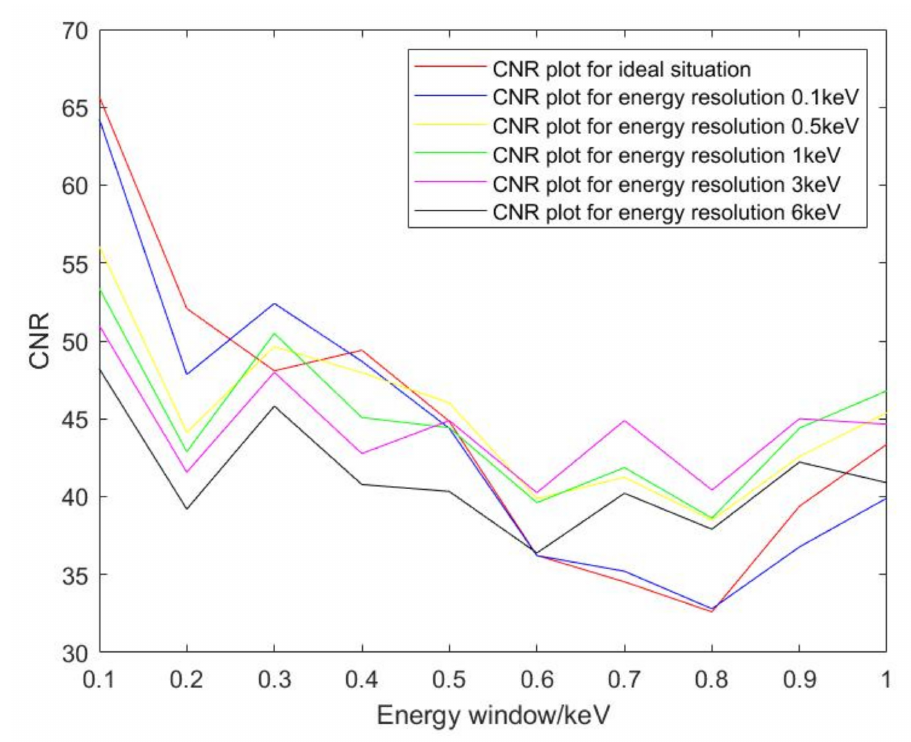
Figure 20. CNRs under different energy resolutions and energy windows for 5 mg/mL of Au.